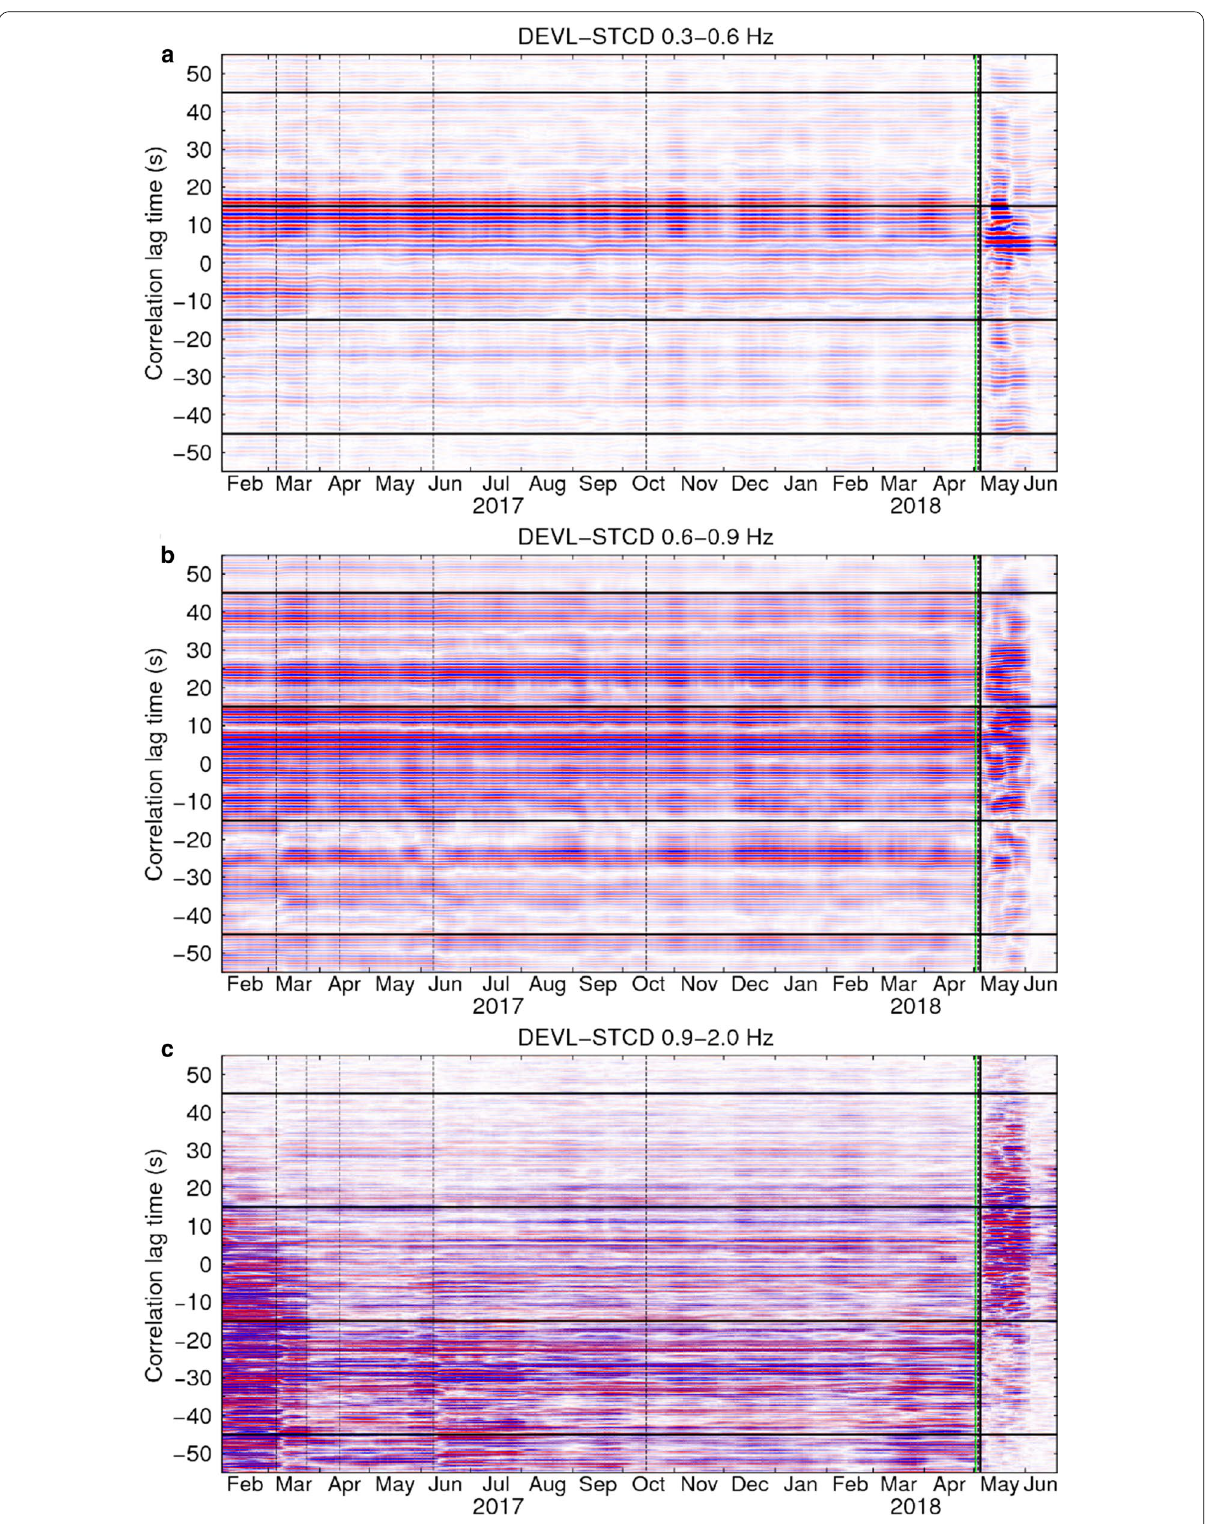
Fig. 3 Daily cross‑correlation functions for station pair DEVL–STCD. a 0.3–0.6 Hz. b 0.6–0.9 Hz. c 0.9–2.0 Hz. Black boxes denote the used coda windows. Vertical dashed lines show the occurrence times of the earthquakes ( M ≥ 3.5 ) before the greatest one ( M w 6.9 earthquake on May 4). The green line marks the beginning time of the 2018